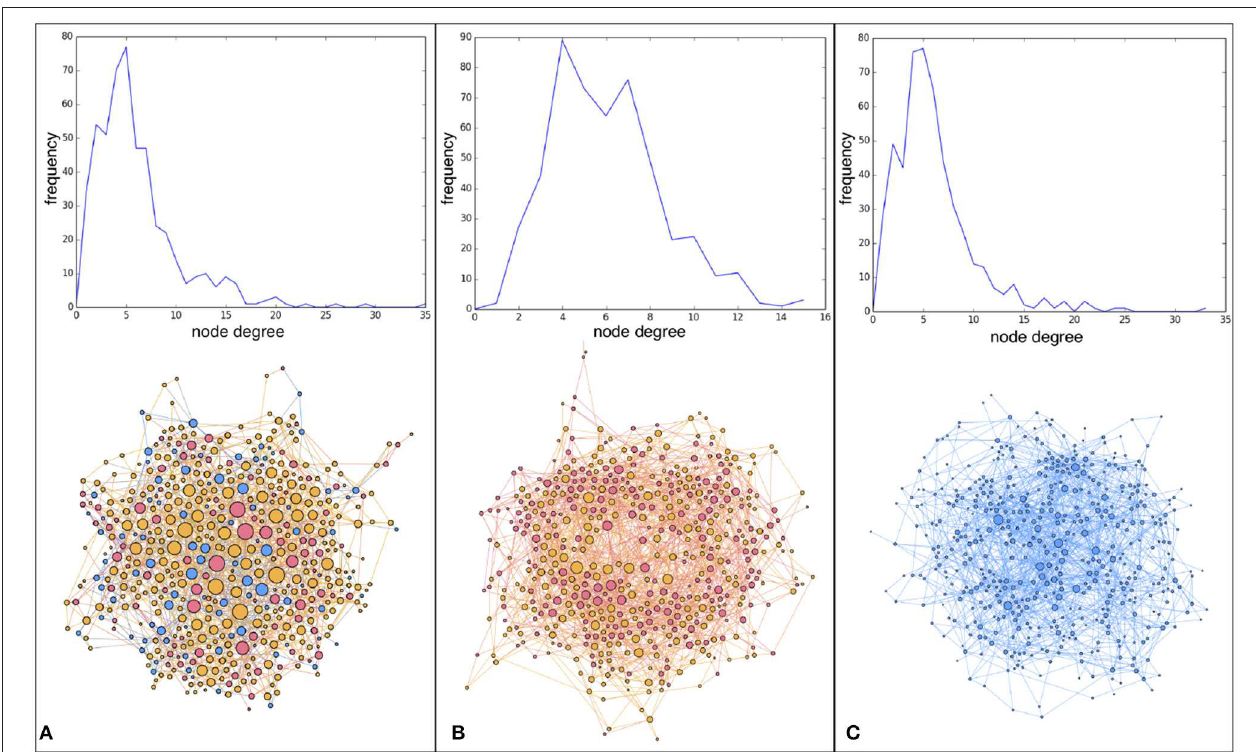
FIGURE 4 | Degree distribution functions (DDFs) and graphical representation of the corresponding network structures. Node colors represent the node contribution to the common pools in which it participates: full contribution (blue), intermediate contribution (yellow), no contribution (red). Node size corresponds to the node degree. (A) DDF of an initial network of 500 nodes built according to the procedure described in Antonioni and Tomassini [34]. (B) DDF of the evolved network after 40 rounds of play with a link redirection probability p = 0.5 and an enhancement factor r = 1.2. (C) DDF of the final evolved network after 40 rounds of play having rewiring probability p = 0.5 and enhancement factor r = 2.4. Note the different scales in DDFs and figure zooms.